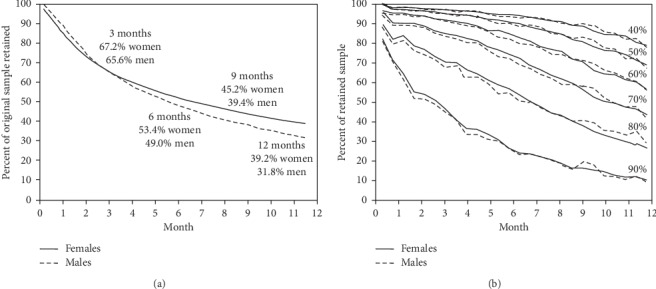
(a) Retention (as a percentage of all 22,407 participants who enrolled) and (b) attendance (as a percentage of completers at each time point). JumpstartMD patients had a financial enticement to terminate the program early, which is not the case for clinical trials or subscription weight loss programs. Specifically, clinical trials subjects consent to participate in a no-cost program for a specified duration and subscribers prepay for a specified program length. In contrast, JumpstartMD patients pay a significant fee to receive their initial evaluation and recommendations and separately pay significant fees to participate on a month-to-month basis without obligation for as long as they perceive benefit from the program.